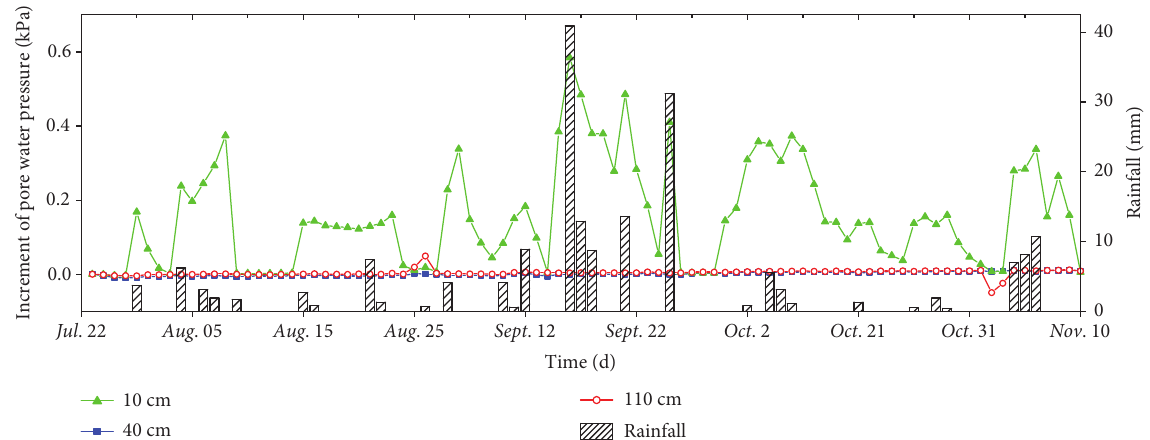
Figure 7: Time history curve of pore water pressure at different depths of slope (slope surface).